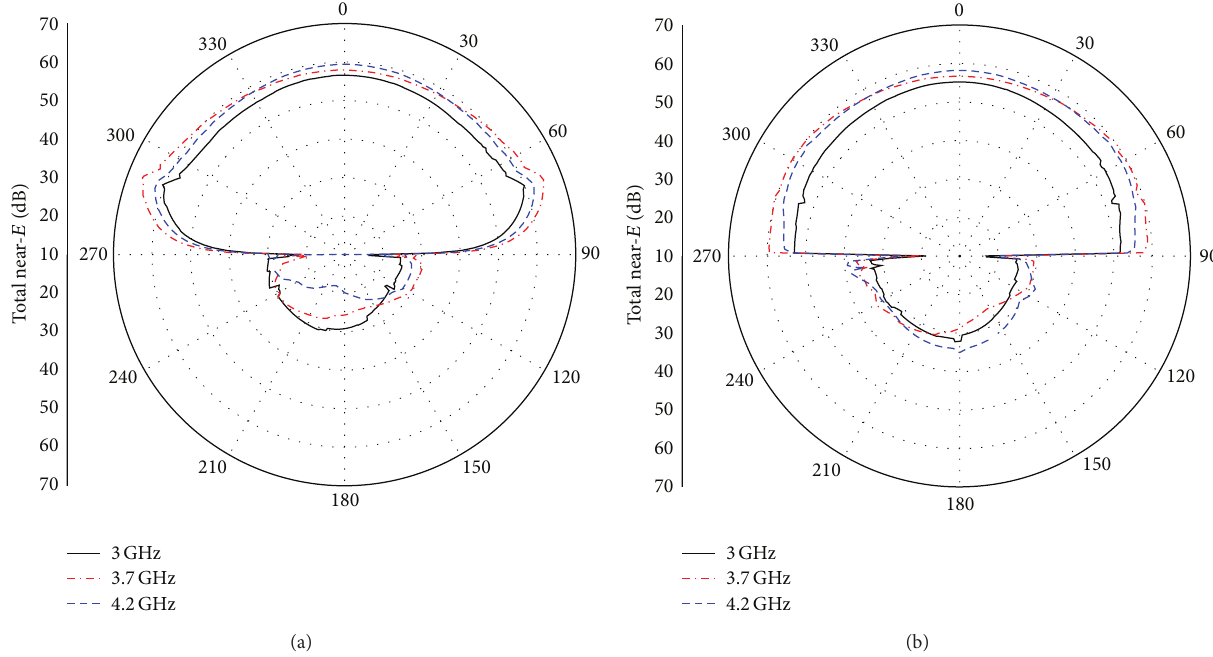
Figure 6: The simulated near field radiation at the three frequencies of 3GHz, 3.7 GHz, and 4.2 GHz. (a) With side wall. (b) Without side wall.